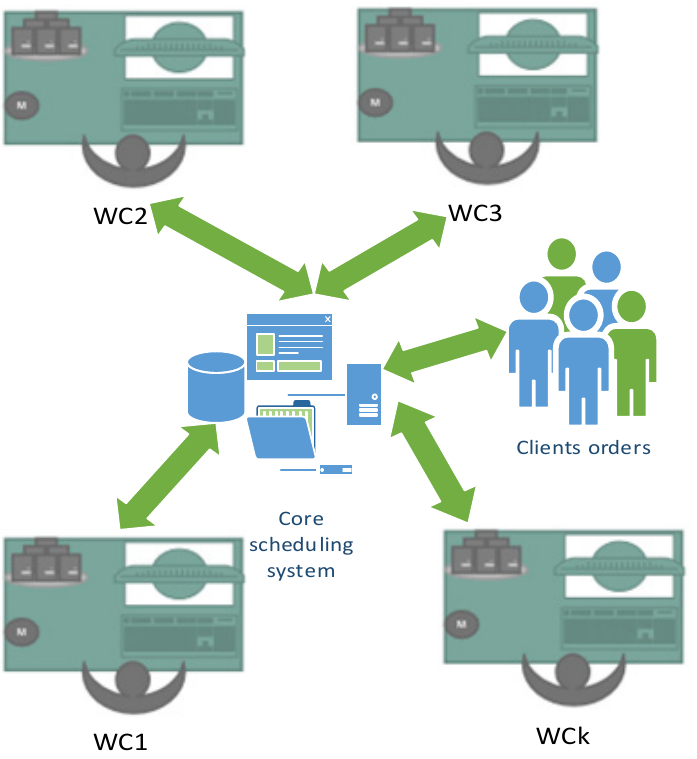
Figure 2. Interoperable manufacturing scheduling system architecture.